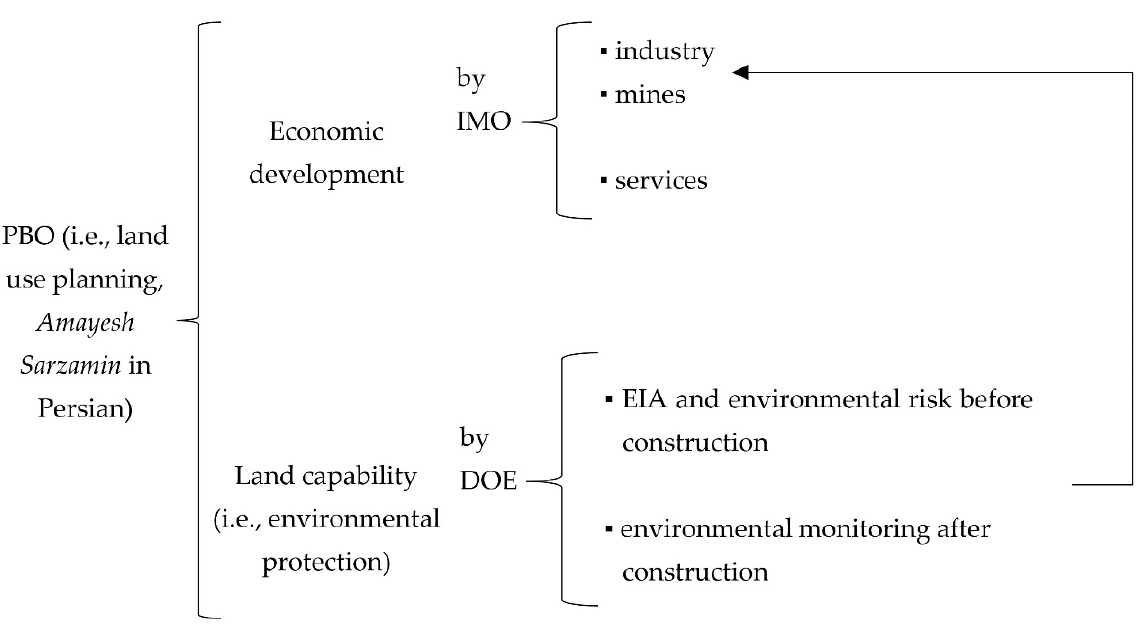
Figure 3. A simple game tree of industrial development conflicts in Markazi province.